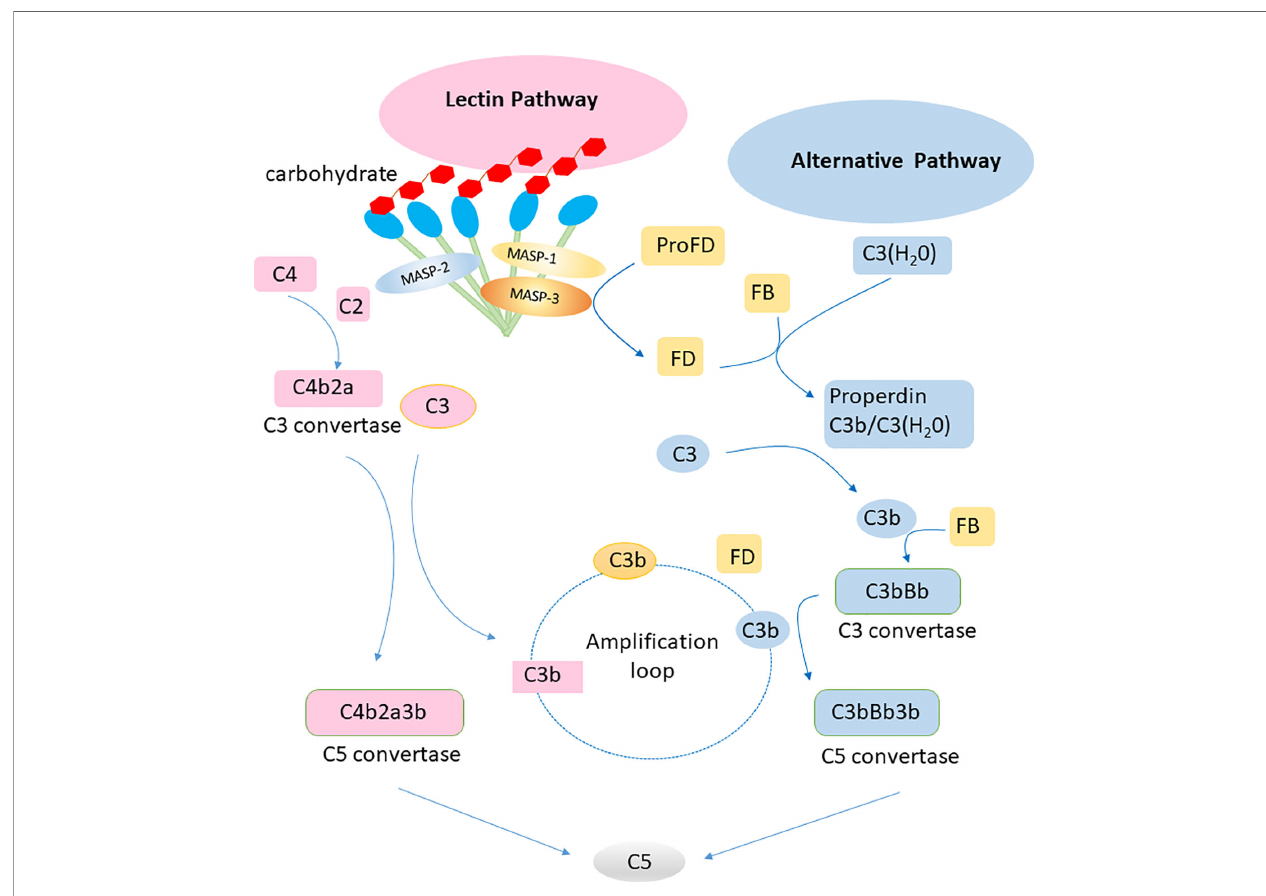
FIGURE 2 | Lectin pathway and alternative pathway of the complement system. Collectins (including MBL, CL-L1, CL-K1 and the complex of the latter CL-LK complex) recognize carbohydrates on surface of pathogens and activate the lectin pathway via MASP-1 and MASP-2. The alternative pathway is activated by spontaneous hydrolysis of C3. Factor D is a rate limiting factor for generation of the C3 convertase in the alternative pathway, which is activated by MASP-3. The alternative pathway works as an ampli fi cation loop for the lectin